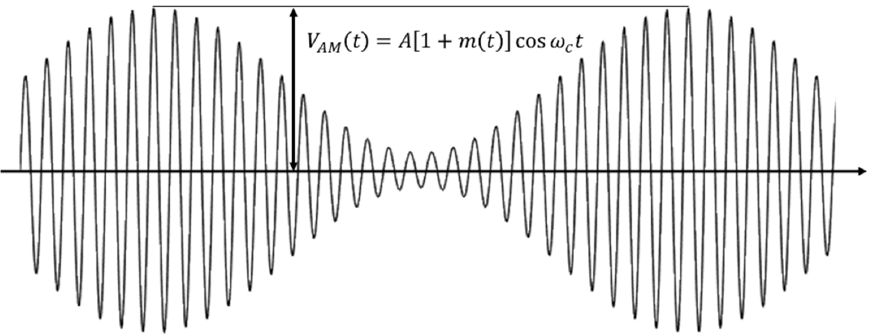
Figure 2. Amplitude-modulated BCI signal, modulation index m = Figure 2. Amplitude ‐ modulated BCI signal, modulation index m = 0.8.